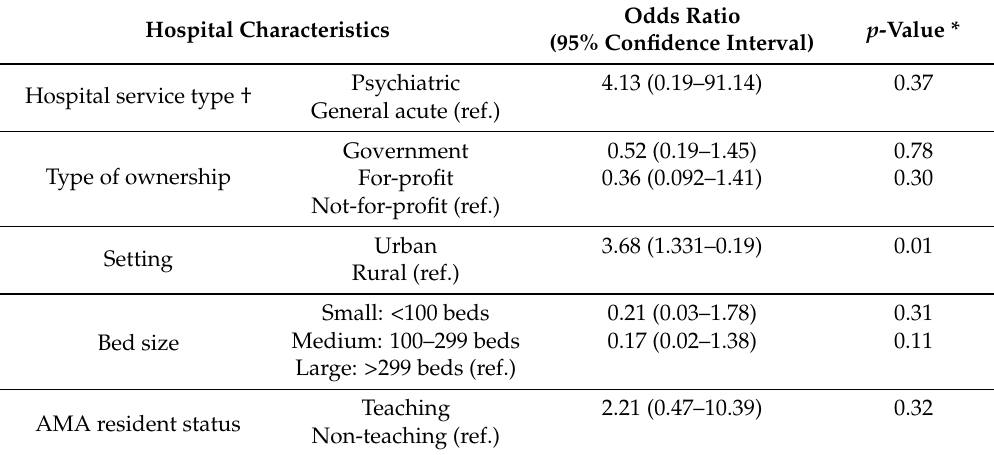
Table 2. Predictors of an existing e-cigarette policy ( n =